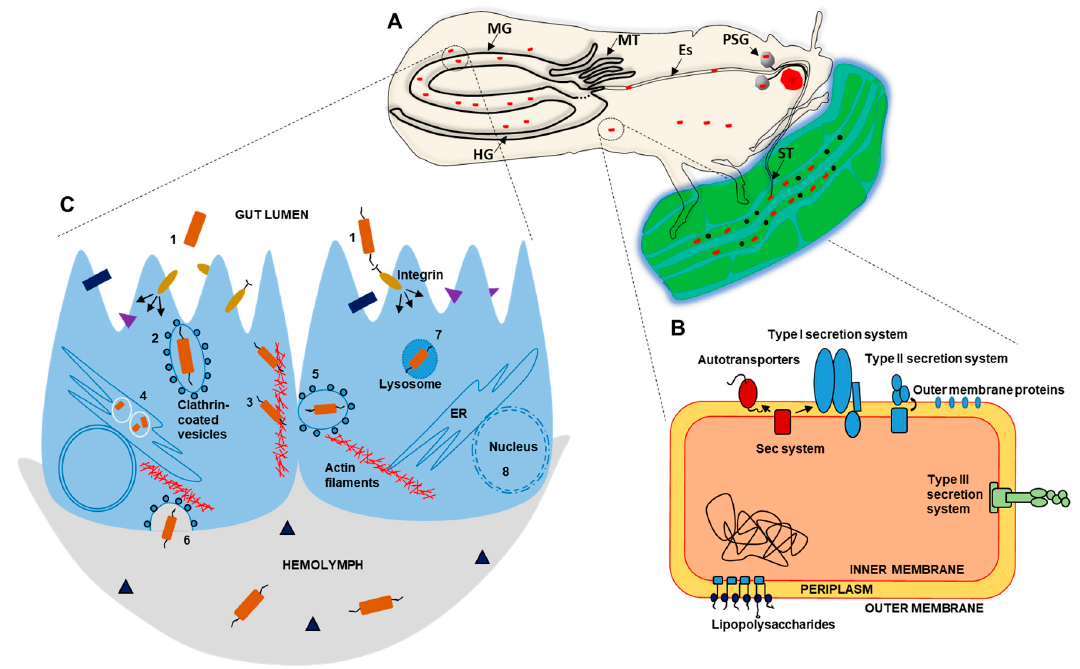
Figure 1. Schematic illustration depicting the major proteins and processes involved in psyllid–liberibacter interaction. ( A ) General internal anatomy of a psyllid during feeding on a plant leaf, specifically acquiring liberibacter from the phloem (red particles) and not the other particles (black dots), and also showing the midgut (MG), hindgut (HG), malpighian mubules (MT), esophgus (Es), primary salivary glands (PSG), and stylet (ST). ( B ) Known protein secretion systems of liberibacters, and ( C ) liberibacter invasion and manipulation of host cell factors needed for dissemination inside the psyllid. ( B ) Liberibacters are known to have all the Sec dependent protein secretory systems, including autotransporters, Type I secretion system (T1SS), and Type II secretion system (T2SS), together with the incomplete Type III secretion system (T3SS) associated with the flagella as a Sec-independent secretion pathway. Initial attachment through these systems (adhesins and T3SS) initiates the secretion of the virulence factors and effectors. ( C ) Once the bacterium binds to the host cell through integrins and vinculins, (1) it initiates an essential signal cascade helping it to be endocytosed (2) by clathrin-coated vesicles. Once released in the host cytosol, the bacteria manipulates the host actin cytoskeleton for locomotion (3). Liberibacters find a suitable niche in the host ER, and recruit ER membrane structures to form vacuoles (4) for multiplication and avoiding host immunity. Using host cytoskeleton, liberibacters are engulfed by the neighbouring cells (5) for cell-to-cell spread. Finally, after exocytosis, it reaches the hemolymph (6) where it circulates and can reach the salivary glands for transmission. However, liberibacters cannot always escape host immunity with induced apoptosis (host cell death) by engulfment of the bacteria inside the lysosomes (7) and nuclear disintegration (8).